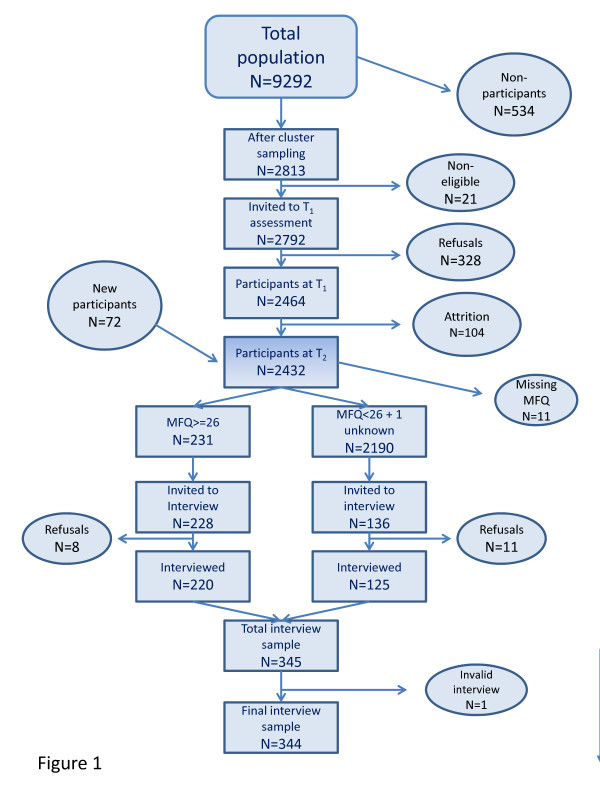
Flow-chart of the Youth and Mental Health Study in Central Norway. The flow-chart shows the numbers of participants in the various stages in the project.